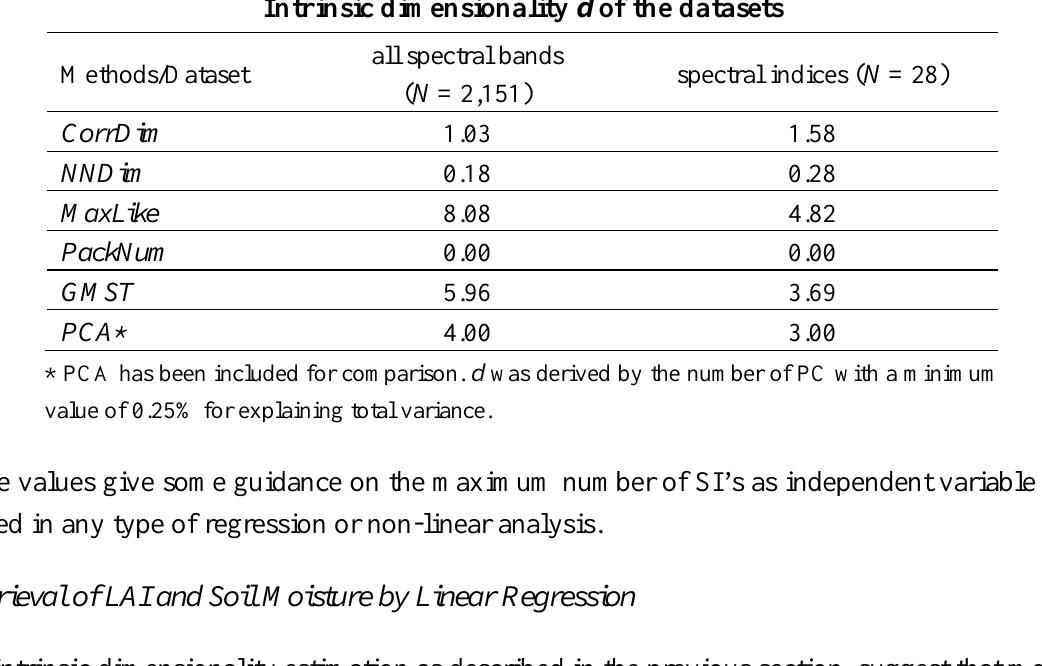
Table 3. Estimated intrinsic dimensionalities (d) of the complete spectral dataset including all spectral bands and of the dataset given by the pre-selected spectral